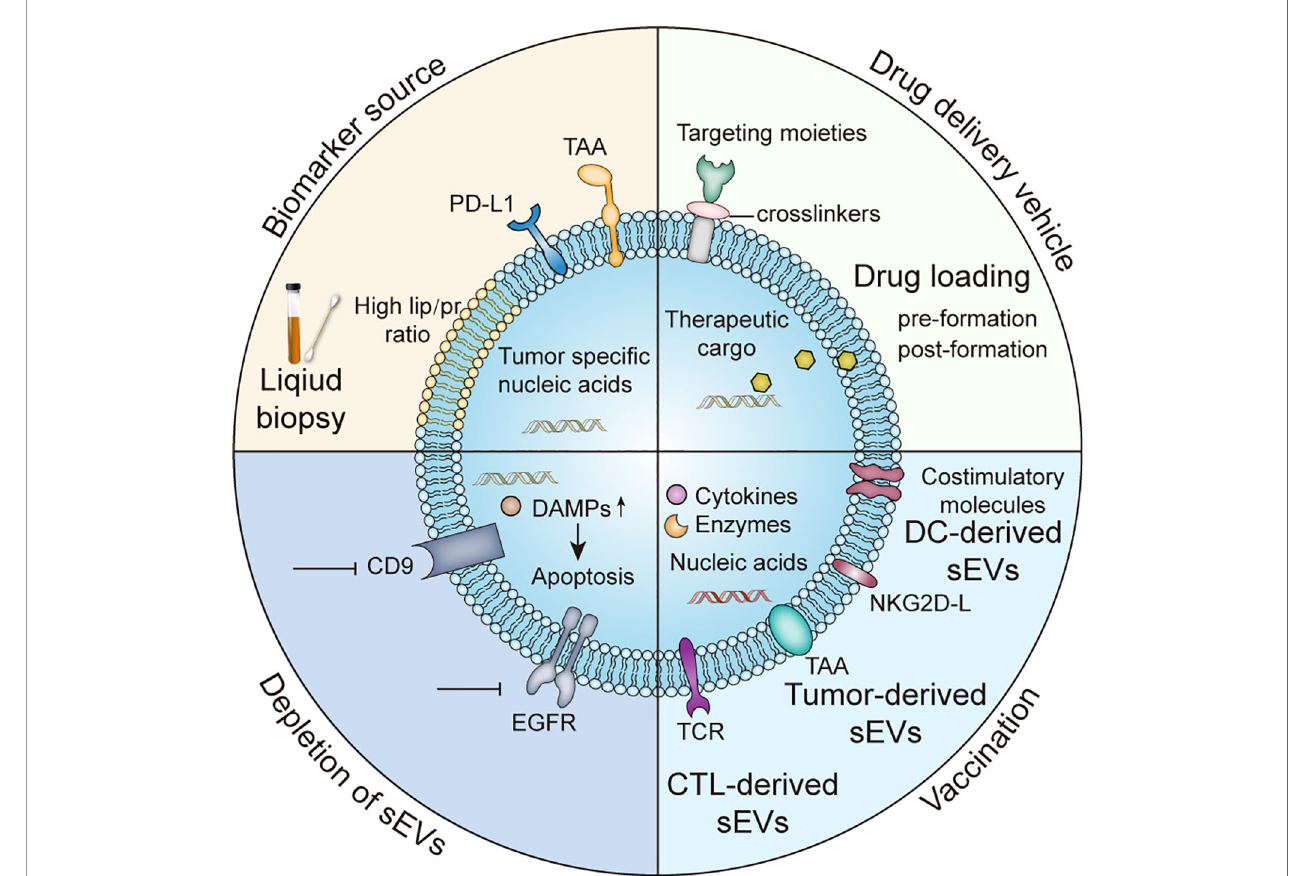
FIGURE 2 | Clinical applications of sEVs TAA, tumor-associated antigens; DAMPs, damage-associated molecular patterns; NKG2D, Natural Killer Group 2D receptor